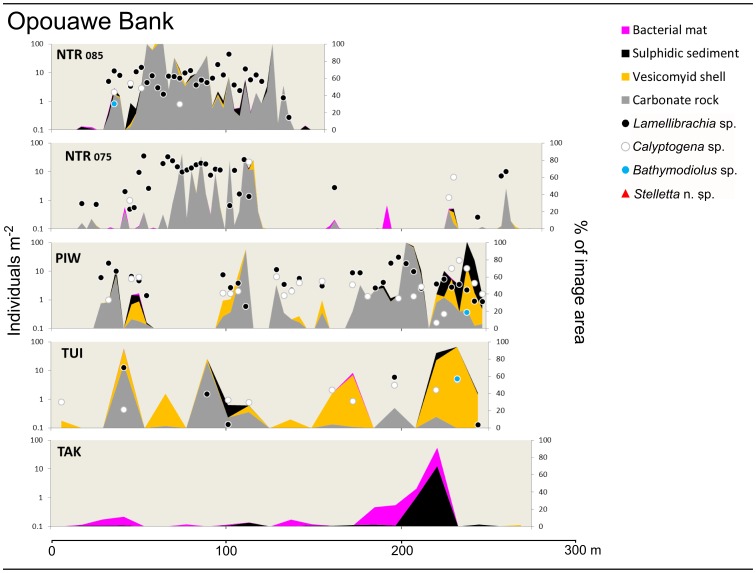
Representative profiles across selected seep sites at Opouawe Bank.Site name abbreviations: NTR, North Tower; PIW, Piwakawaka; TUI, Tui; TAK, Takahe (numbers on North Tower profiles show station numbers; see Figure 4. Station numbers for other sites: PIW, SO214-070; TUI, SO191-129; TAK, SO214-065). Data are from analyses of still images taken during towed camera transects across each site. Point markers show population densities of seep-associated fauna (individuals m−2, log scale, left y-axis), area fills show substratum type as proportion of the full image area (% of image area, right y-axis). Profiles are scaled to horizontal distance travelled (x axis).